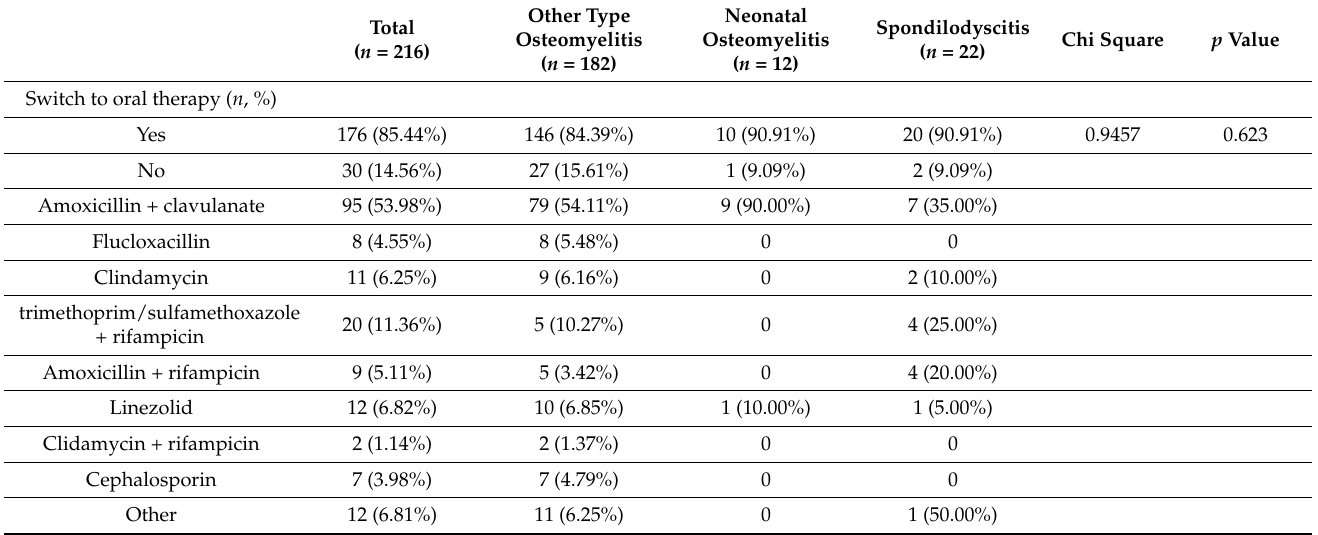
Table 6. Switch to oral antibiotic